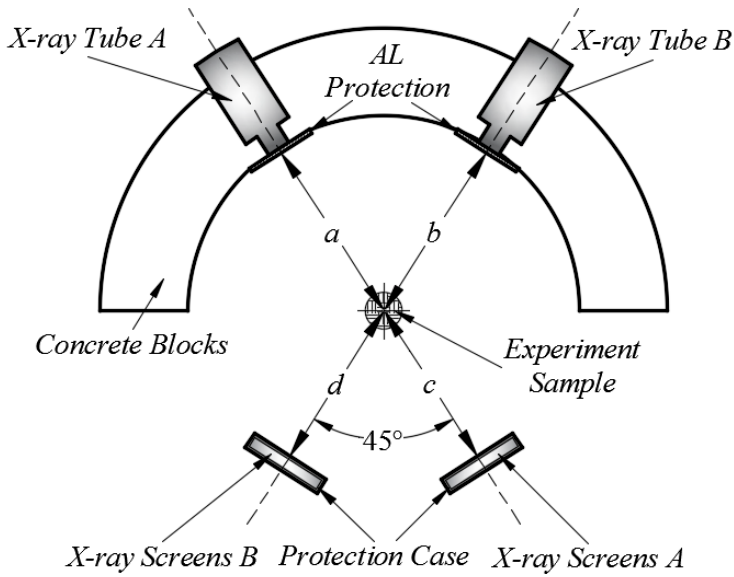
Figure 17. Schematic of the X-ray experiment layout.